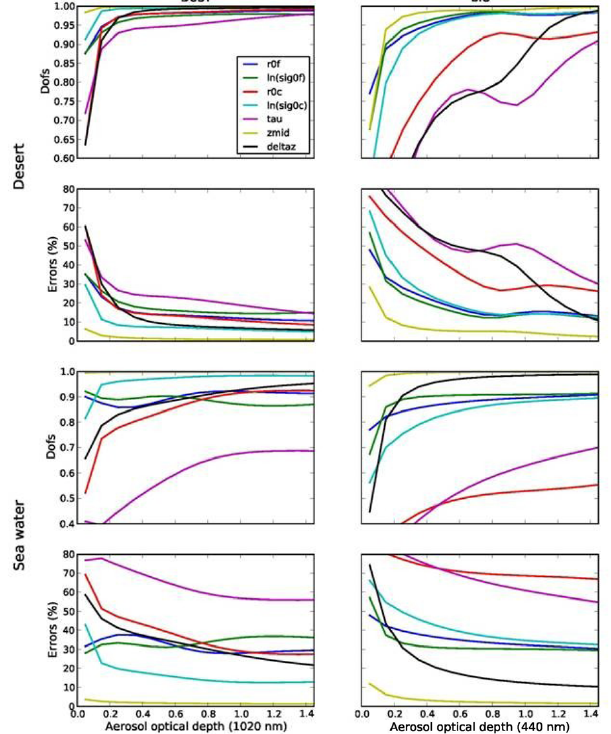
Fig. 3. DOFSs and total error (in %) for each aerosol parameter of the state vector. τ is AOD, r mean radius, and ln( σ) deviation of the radius. The f and c indices are for fine and coarse mode respectively. Z mid and 1Z are center height and width of the aerosol layer.